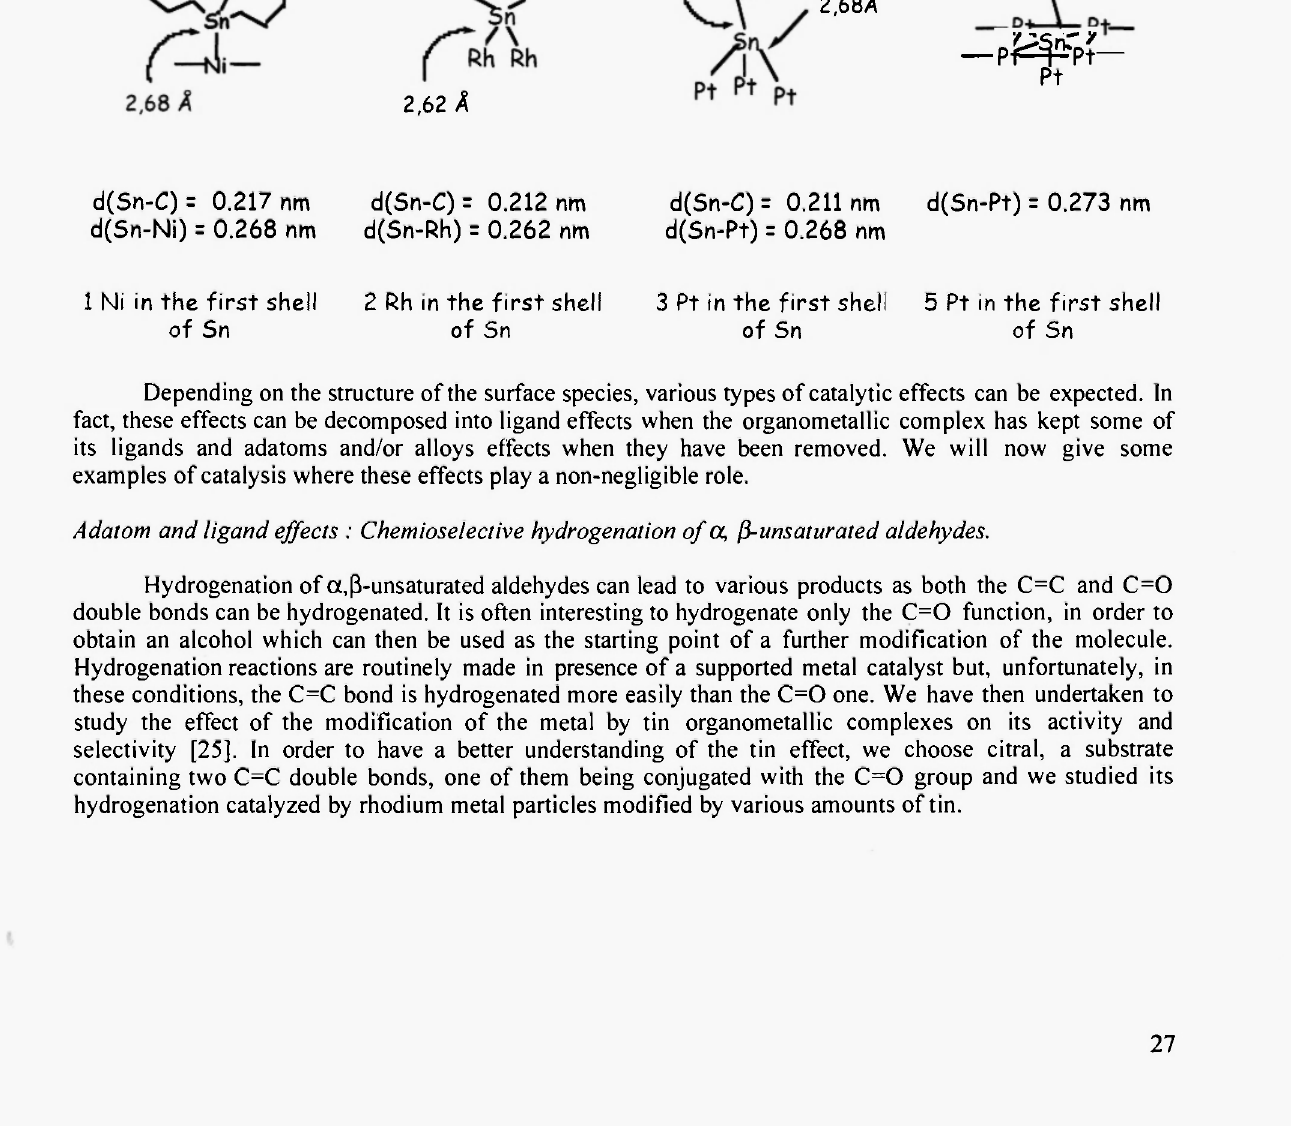
Figure 12 : Stepwise hydrogenolysis of SnRj compounds on metal particles and resulting aspect of the metal